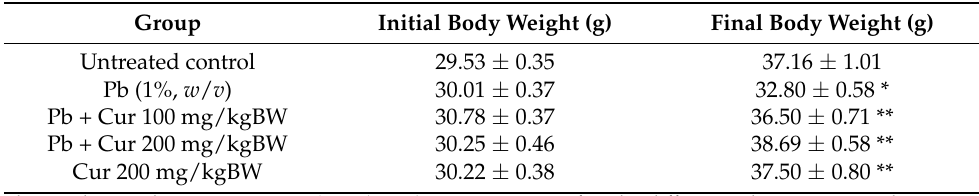
Table 1. Effect of curcumin on mice body weight changes in lead-exposed mice.